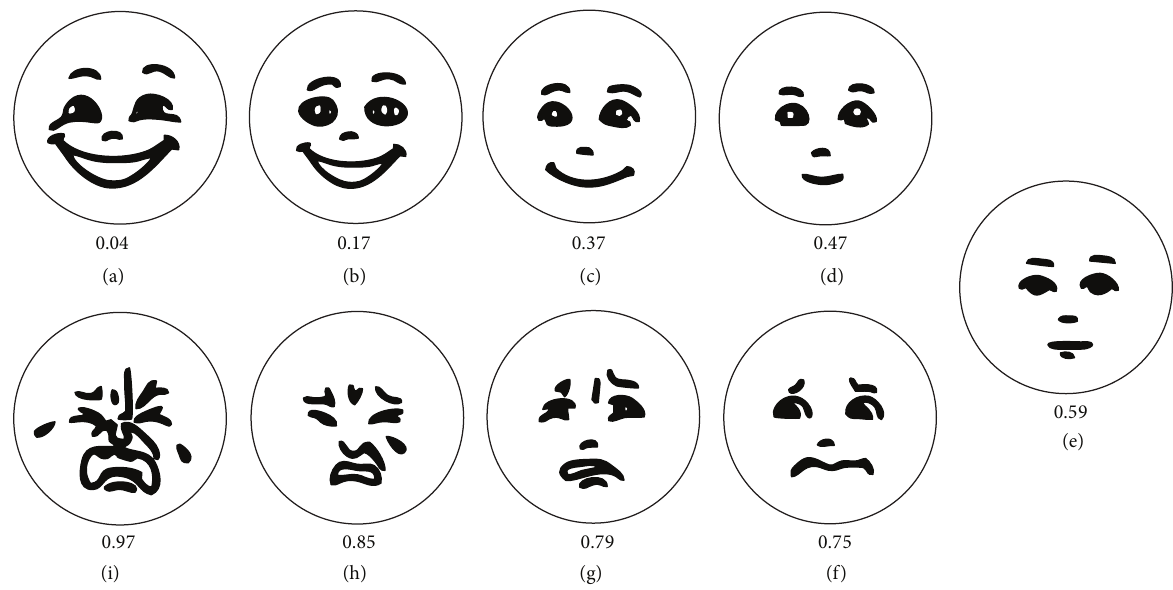
Figure 1: The facial affective